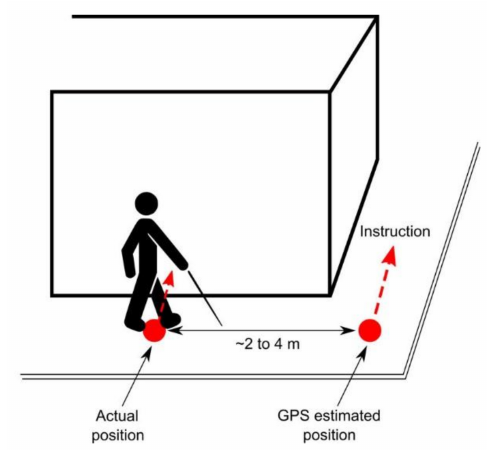
Figure 7. An eventual situation involving GPS